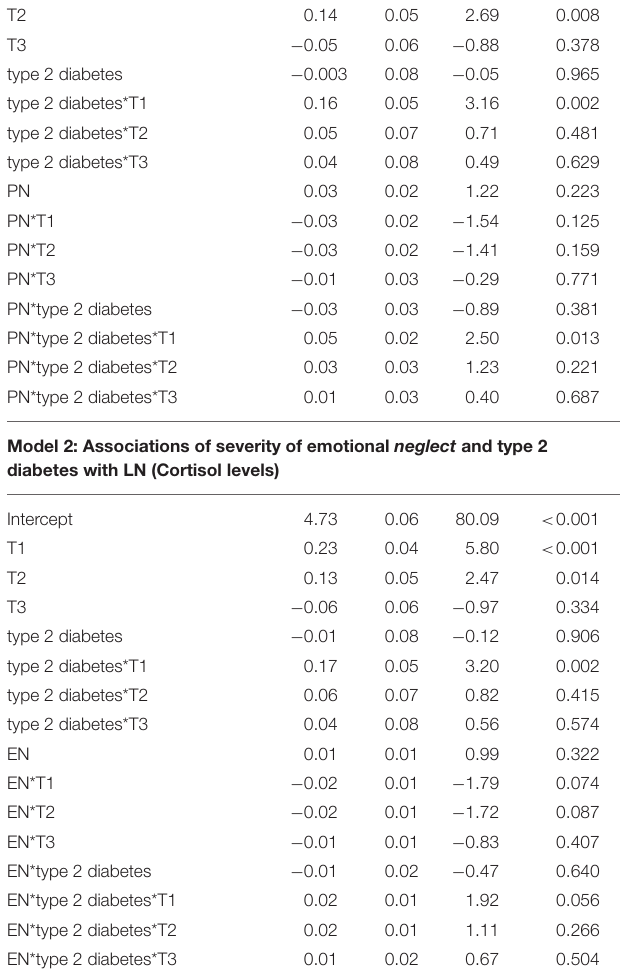
TABLE 5 | Multilevel models on plasma cortisol levels: estimates of fixed effects. Parameter Estimate Model 1: Associations of severity of physical neglect and type 2 diabetes with LN (Cortisol levels) Intercept